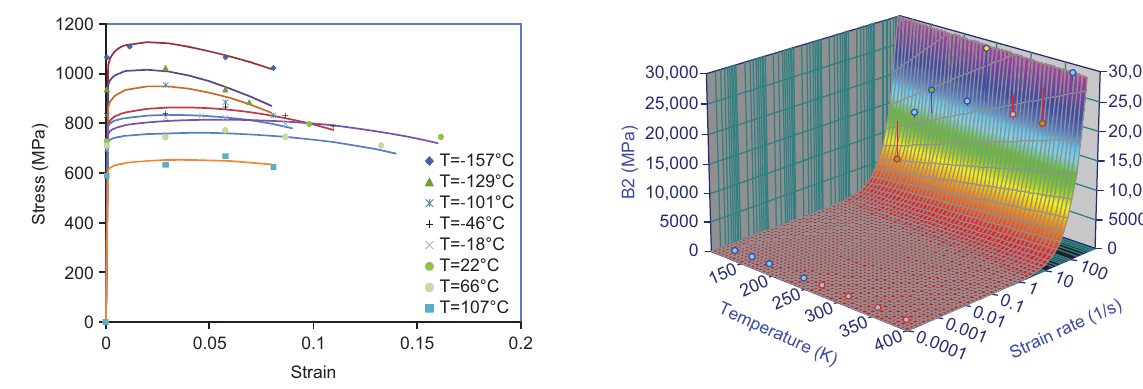
Figure 2 Stress-strain curves of CR-1018 steel for a wide range of temperatures at a shear strain rate of 5 × 10 2 /s.